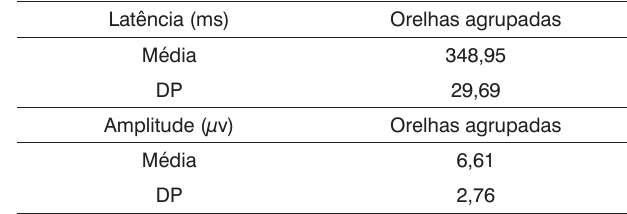
Tabela 1. Média, Desvio Padrão (DP) e p -valores, referentes às latências e amplitudes do P300 para estímulos não verbais em orelha direita (OD) e orelha esquerda (OE).